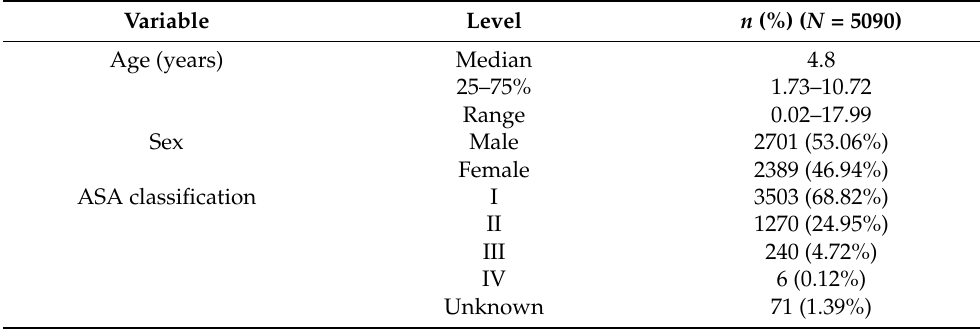
Table 1. Summary of the demographics of patients receiving pediatric procedural sedation.